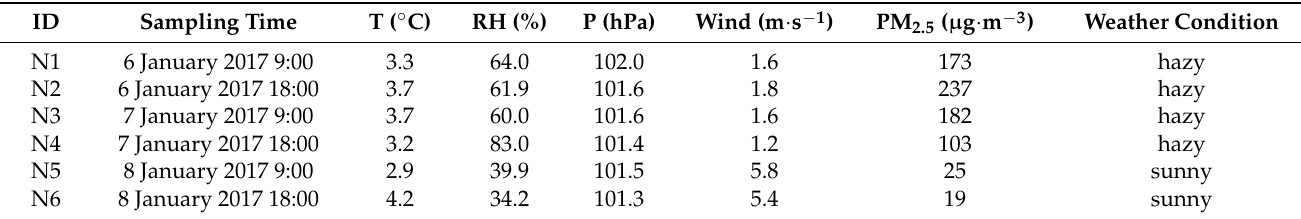
Figure 1. Sampling locations and the major urban roads around the Xueyuan Road. Table 1. Time and weather conditions of sample collection collected.